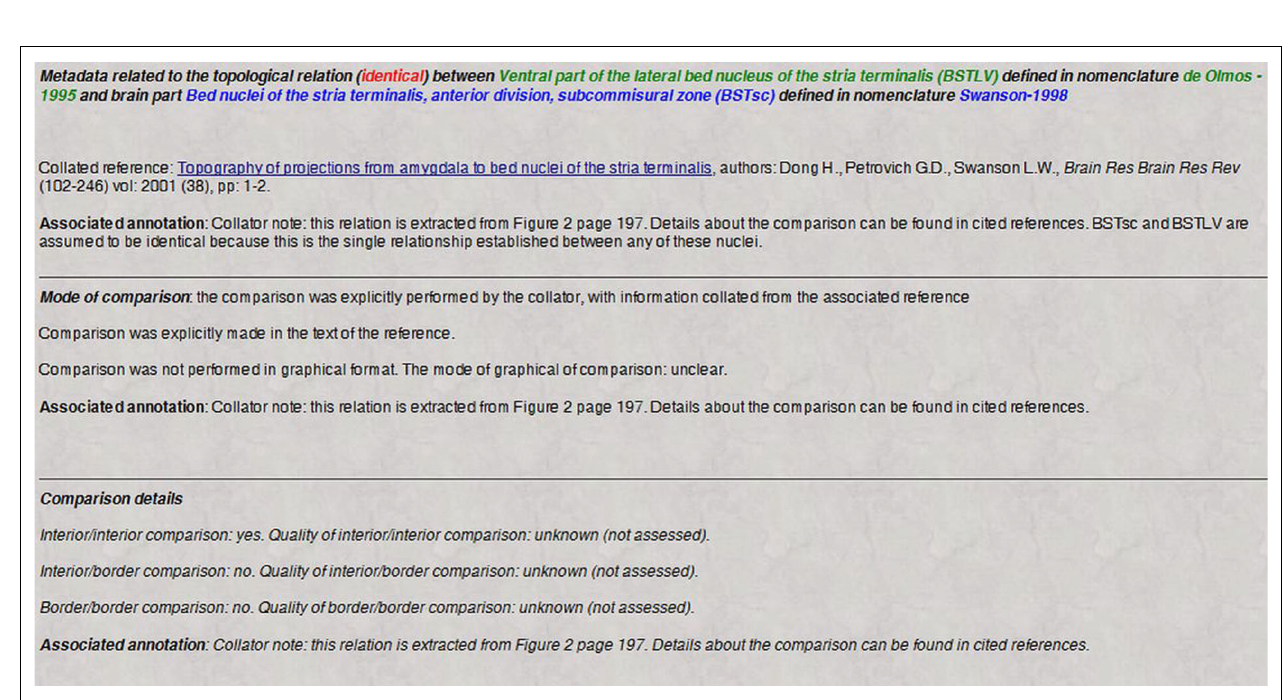
php). The result of the search will include the related regions, their nomenclatures, and associated annotated and metadata. The link “Additional metadata” will lead to details related to the comparison method, shown in Figure 3 (see Text for details).